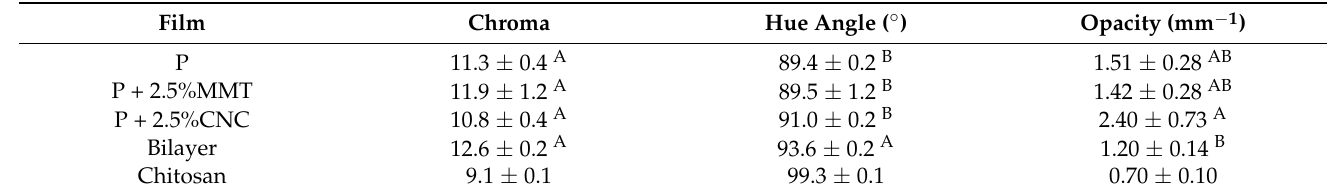
Table 1. Optical properties of the